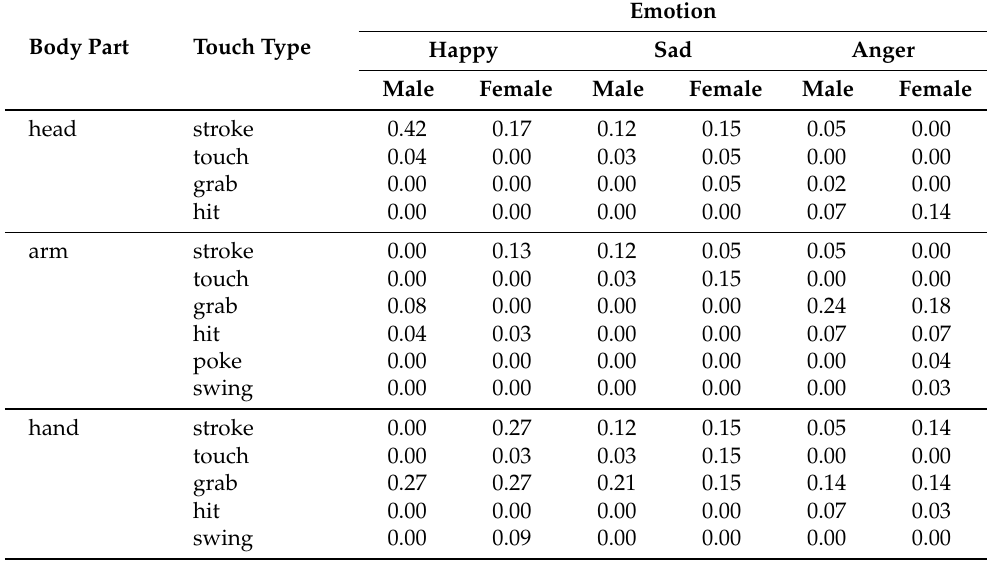
Table 4. Analysis of participant’s